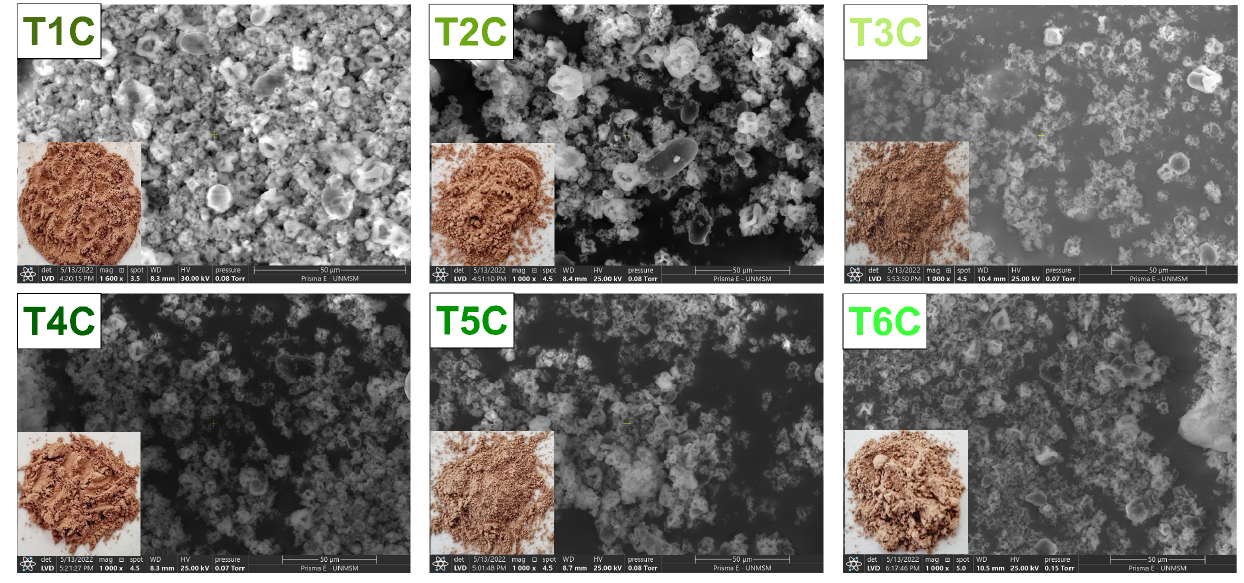
Figure 5. SEM images of the encapsulation at 120 °C (T1C, T2C, and T3C) and 140 °C (T4C, T5C, and T6C) at 1000× magnification. T6C) at 1000 × magnification.